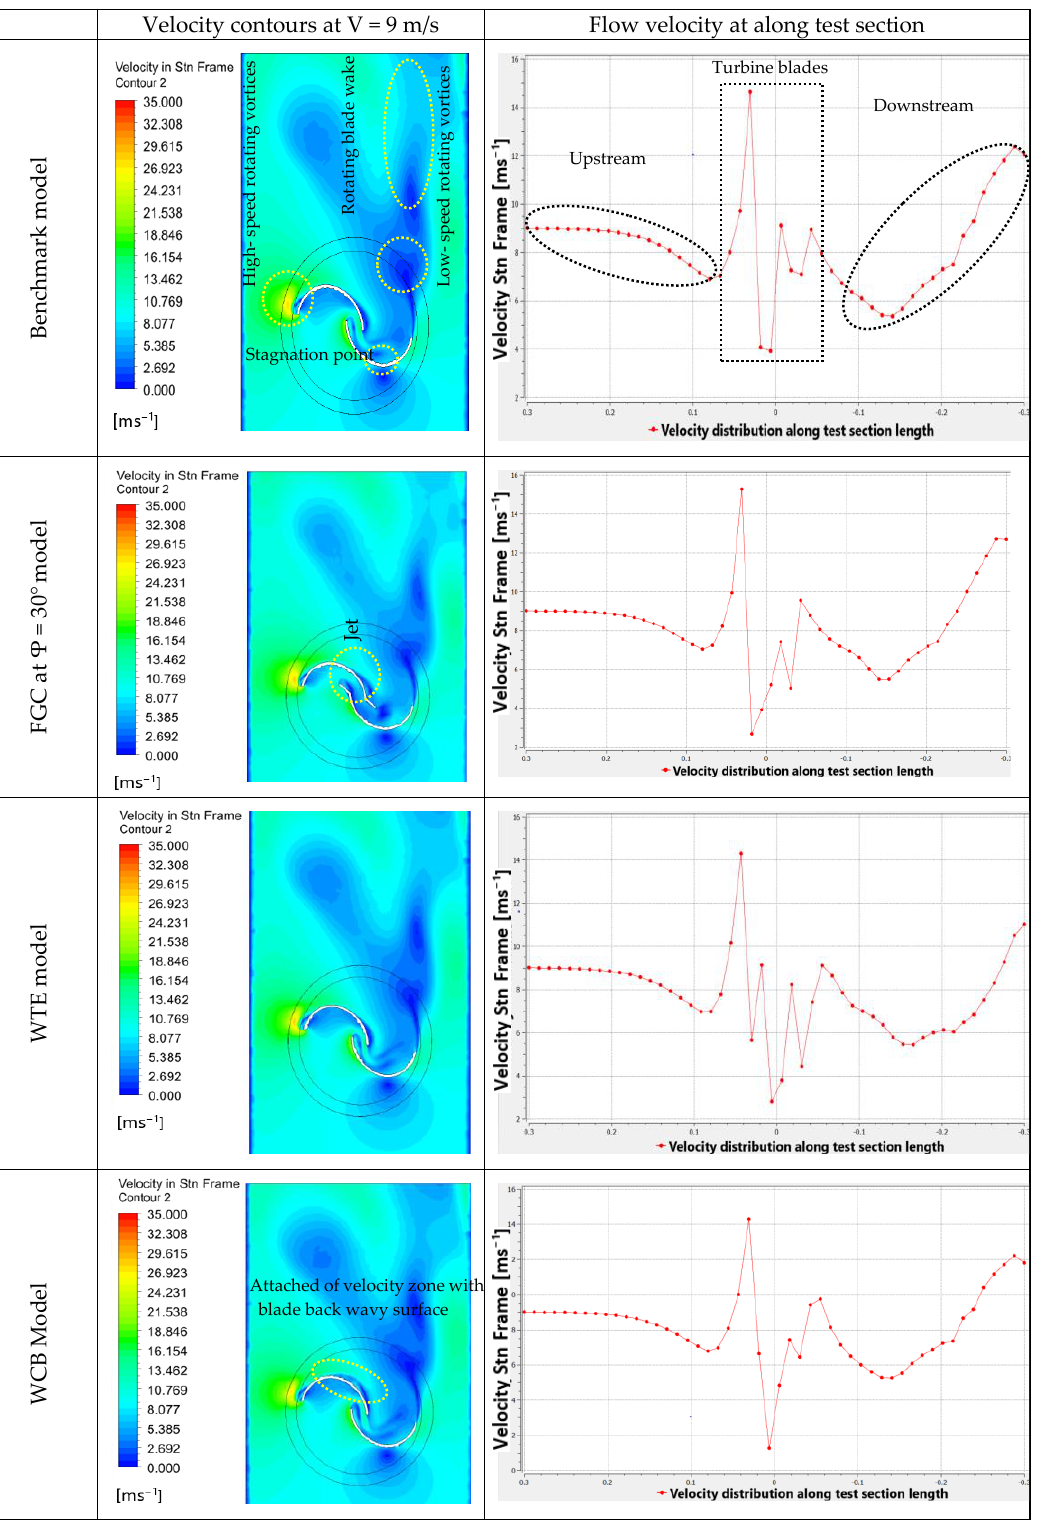
Figure 14. Velocity contours and diagrams for velocity distribution along the test section for TSR 1. Figure 13. Cp max values obtained from analysis of different blade